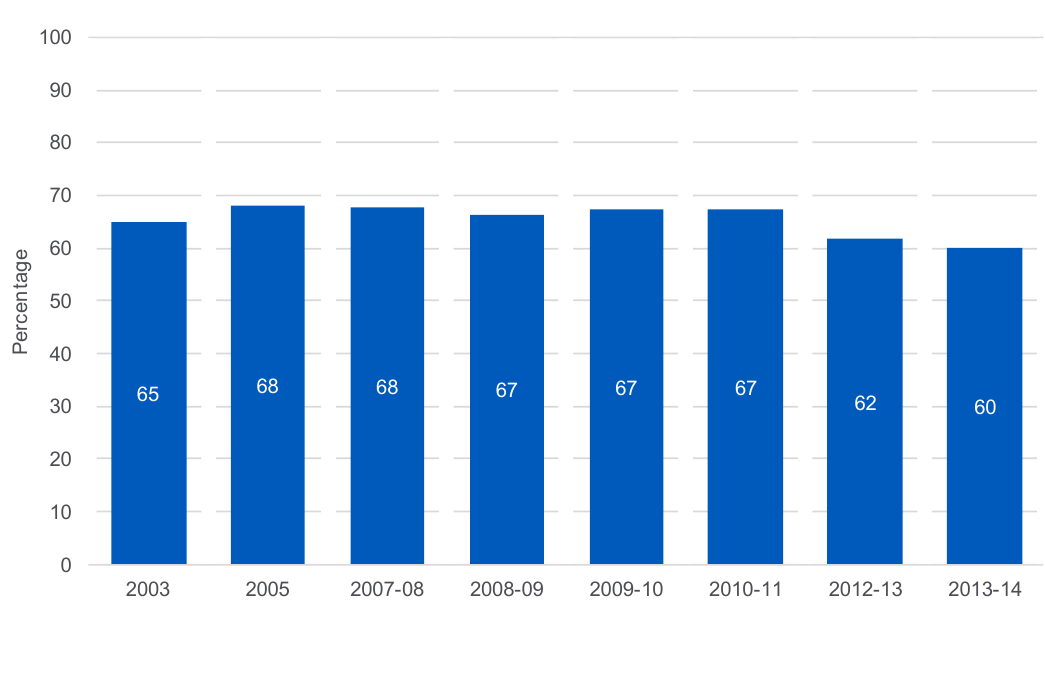
Figure 11: Proportion of people who agree that people in their neighbourhood pull together to improve the neighbourhood, 2003 to